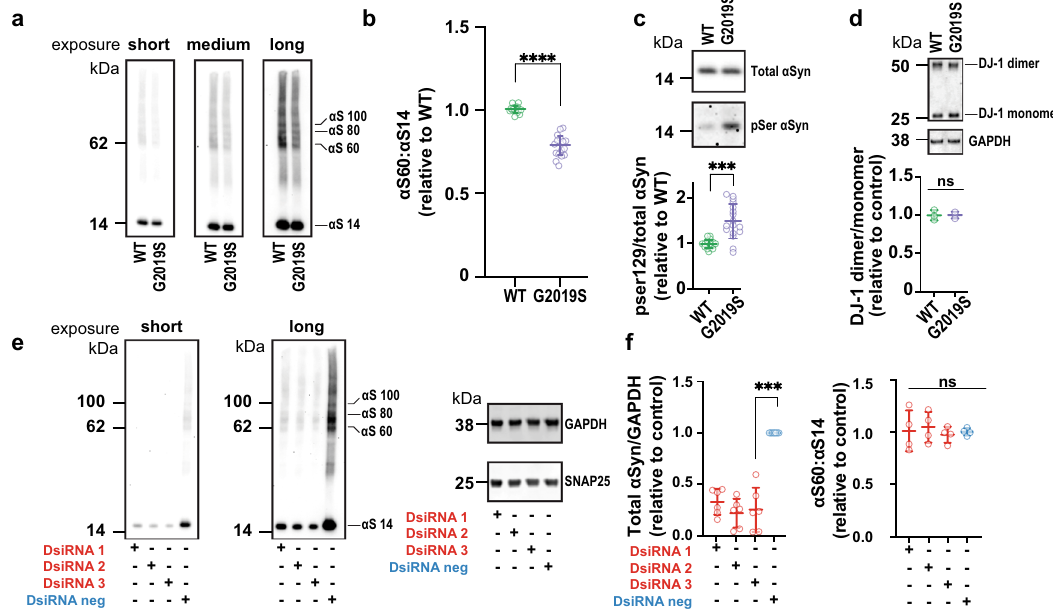
Fig. 2 LRRK2 PD-causing mutations decrease α Syn tetramer:monomer ratios and increase monomer phosphorylation in iPSC-derived patient neurons (iNs). LRRK2 G2019S mutation in each of two different patient lines decreases the endogenous α Syn tetramer ( α S60, numerator) to monomer ( α S14, denominator) ratio. a Representative WB of total lysates prepared after intact-cell crosslinking with 1 mM DSG. Each G2019S patient line has an isogenically corrected (WT) line. b Quanti fi cation ( N = 2 patient lines; n ≥ 5 experiments) of the α S60: α S14 (T:M) ratio in the mutant vs. WT lines. c While total α Syn levels are unchanged by the G2019S mutation, it signi fi cantly enhances pSer129 phosphorylation ( N = 2 patient lines; n ≥ 3). d DJ-1 WB of the same lysates as in A shows uniform crosslinking of the endogenous DJ-1 dimers, excluding differential crosslinking ef fi ciency as the reason for the abnormal α Syn T:M ratio. e Three distinct DsiRNAs to α Syn show that the multimeric bands ( α S60, α S80, α S100) are speci fi c α Syn species and do not alter general protein expression (shown are GAPDH and SNAP25). f While the total α Syn levels are signi fi cantly reduced by all 3 DsiRNAs, the α Syn T:M ratio is not altered. ( N ≥ 8 independent experiments; each dot is the average quanti fi cation of an independent six-well plate experiment; one-way ANOVA with Tukey ’ s post hoc test; error bars: SEM; **** p < 0.0001; *** p < 0.001; ns not signi fi